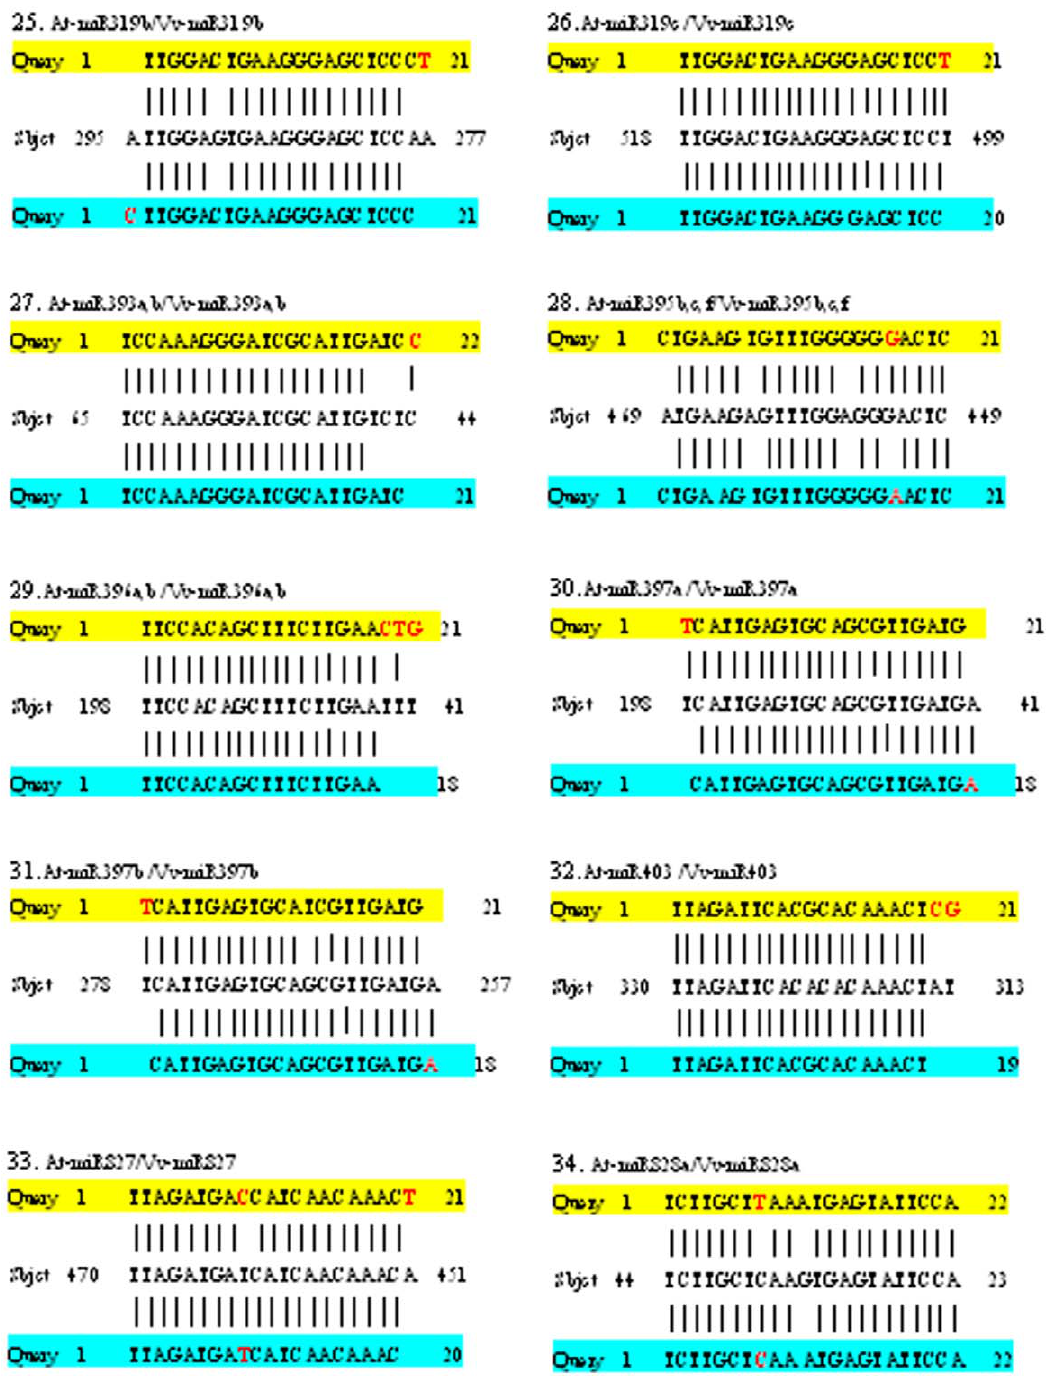
Figure 4. Comparison of the uncomplementary bases of orthologous miRNAs from Arabidopsis and grapevine with the same target sequence (continued). The yellow regions are Arabidopsis miRNAs sequences, the blue regions are grapevine miRNAs, and the middle sequences are the complementary sequences on target genes of grapevine.